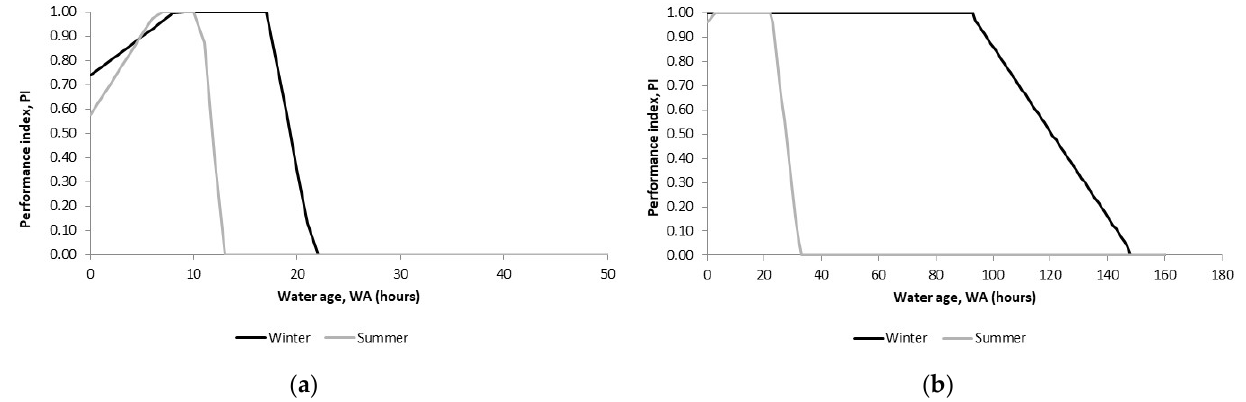
Figure 8. Water age performance curves for ( a ) Case Study 1 and ( b ) Case Study 2.